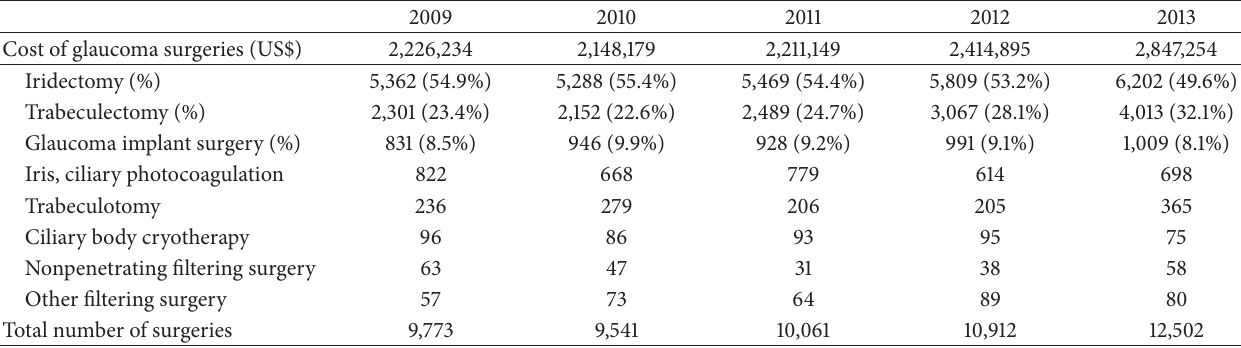
Table 4: The cost and number of glaucoma surgeries (including laser procedures) in Korea between 2009 and 2013 (2008 database was